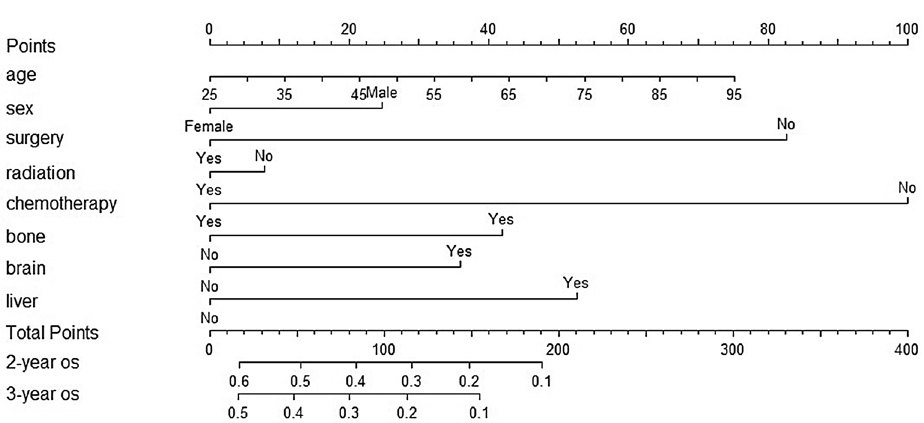
Figure 1. Prognostic nomogram model constructed with advanced